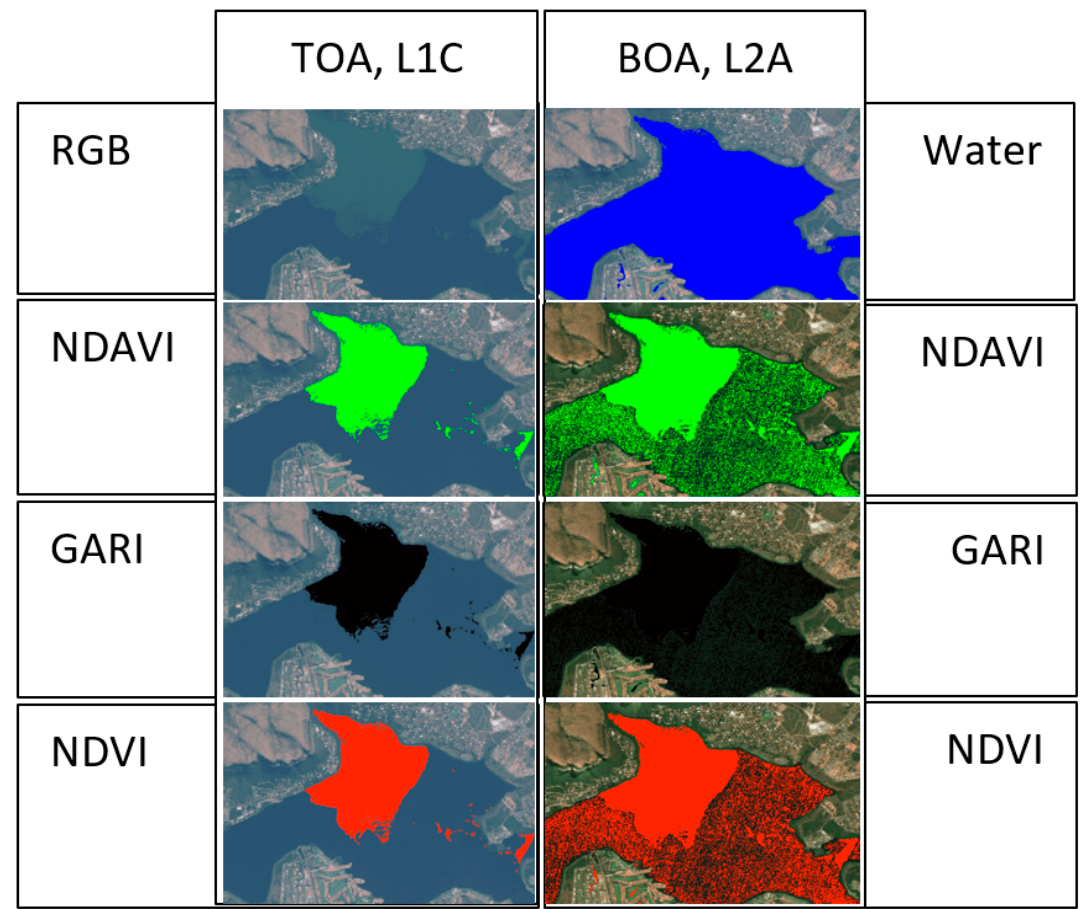
Figure 6. The detection of water ( blue ) and aquatic vegetation derived from three vegetation indices with a varying sensitivity to atmospheric conditions, i.e., normalized difference aquatic vegetation index ( NDAVI ) ( green ) the most sensitive, GARI (black) the least sensitive and NDVI ( red ) with relatively moderate sensitivity from Sentinel-2 Top-of-Atmosphere (left column, TOA, L1C) and Bottom-of-Atmosphere (right column, BOA, L2A) data over a portion of Hartbeespoort dam, South Africa. A visual comparison between the detected aquatic vegetation from the Otsu + Canny and the MultiResUnet approach showed a high correspondence with each other and their associated RGB image (Figure 7). In addition, the predicted outputs correspond to a low validation binary cross-entropy loss / error and high validation accuracy against reference aquatic vegetation generated using the Otsu + Canny algorithm (Table